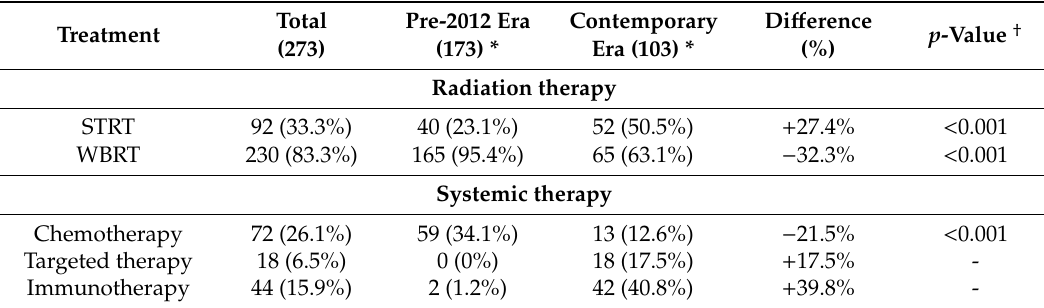
Table 3. Summary of treatment type by